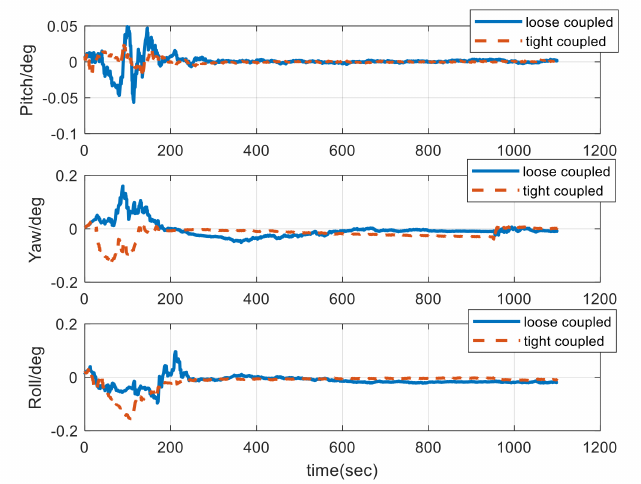
Figure 5. Comparison of attitude errors between loose and tight